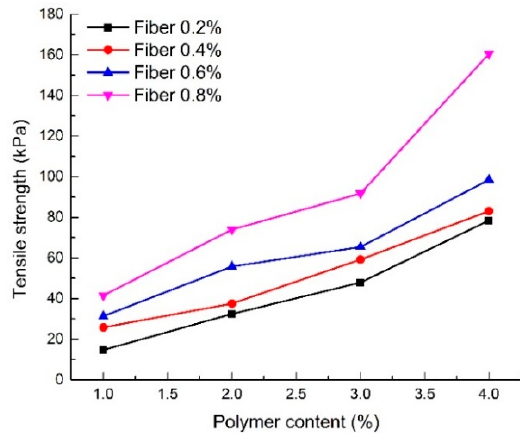
Figure 12. Tensile strength of reinforced sand with different polymer content.